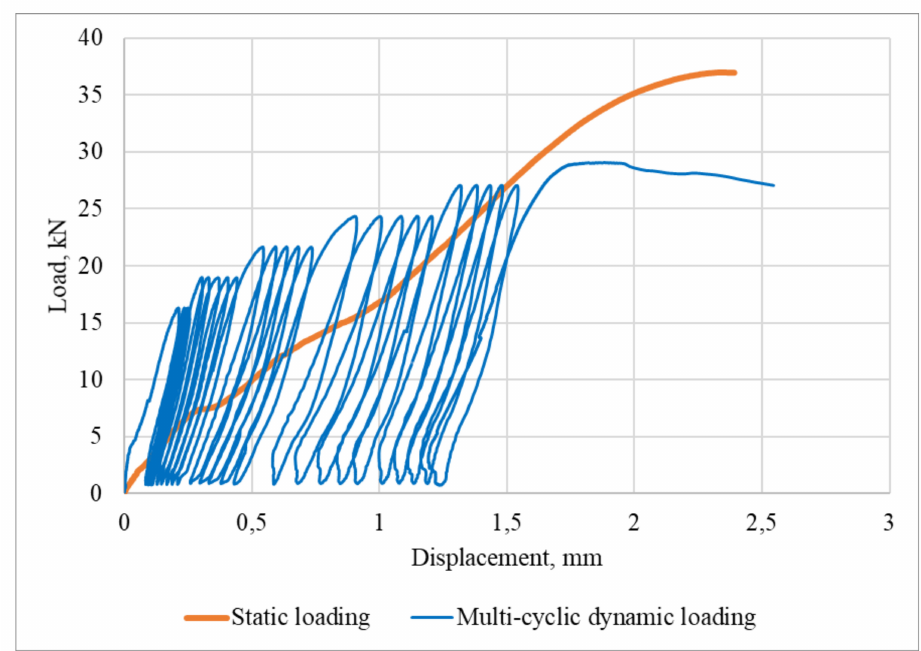
Figure 15. Characteristic load–displacement relationships under static and multi-cyclic dynamic loading, if the anchorage fails at the interface between the adhesive composition and the